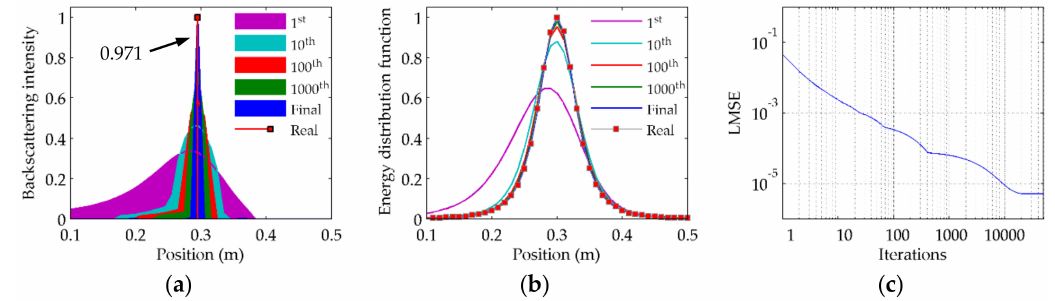
Figure 4. Inversion result for the single scatter scenario. ( a ) presents the distribution of the inverted backscattering intensity during the network training. The results of the 1st, 10th, 100th, 1000th and final iterations are illustrated with different colors (see the legend). Since the initial set is all zeros, it is not visible in the figure. ( b ) shows the fitted energy distribution function. ( c ) gives the evolution of LMSE during the network training, i.e., inversion. Note that both the x - and y -axis are displayed with a logarithmic